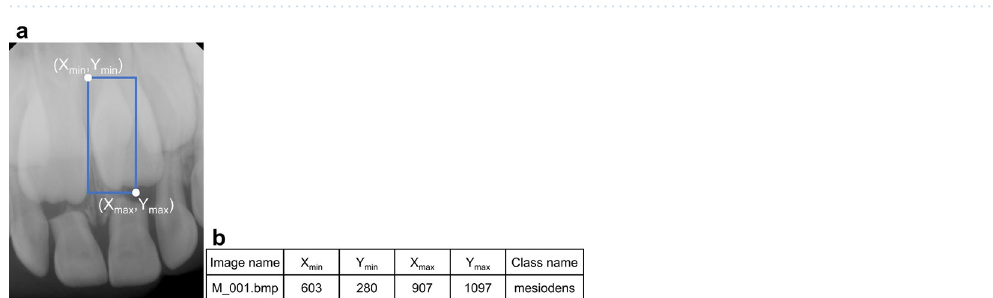
Figure 3. The structure of the EfficientDet-D3 algorithm. BIFPN bi-feature pyramid network, MBConv mobile inverted bottleneck convolution block.